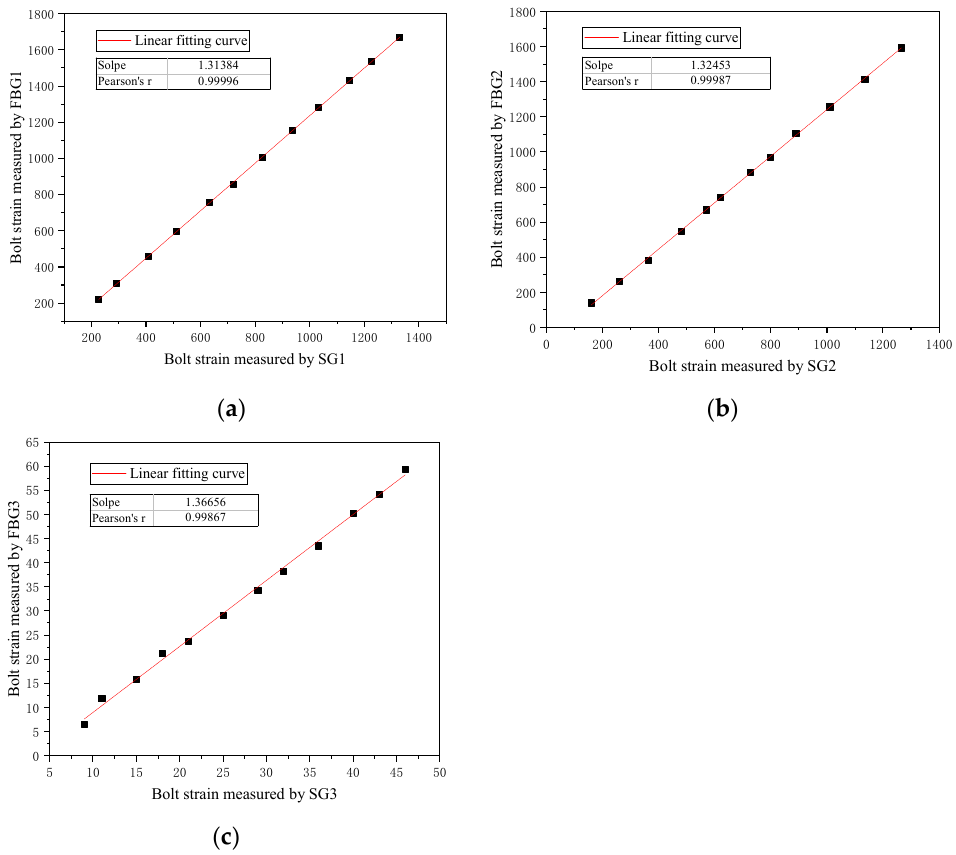
Figure 10. Corresponding relationship between strain measurement values by FBG and SG for ( a ) FBG1, ( b ) FBG2, and ( c ) FBG3.